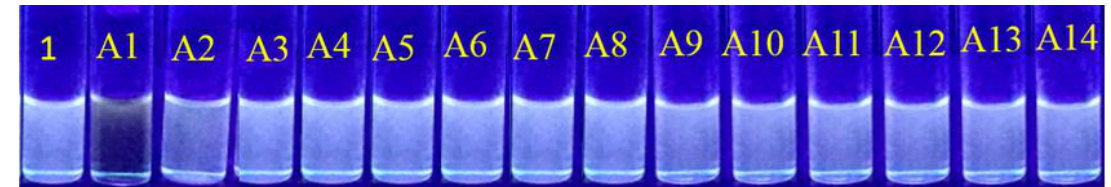
Figure 1. The visual color change under UV-light ( λ max = 365 nm) of receptor solution 1 with the addition of various nitroaromatics ( A1 to A14 ).